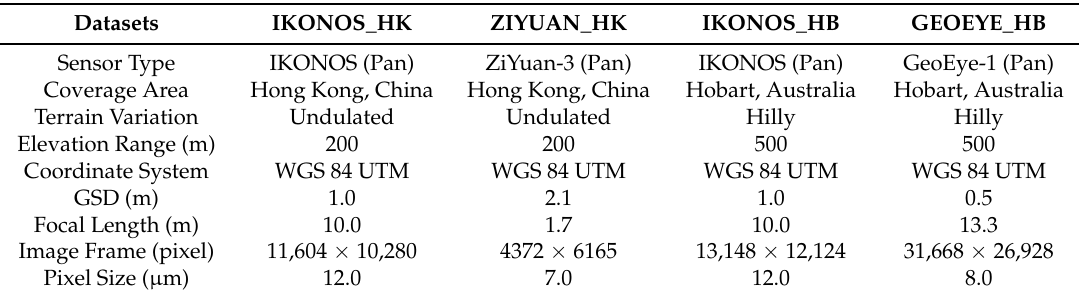
Table 1. Specifications of the four HRSI